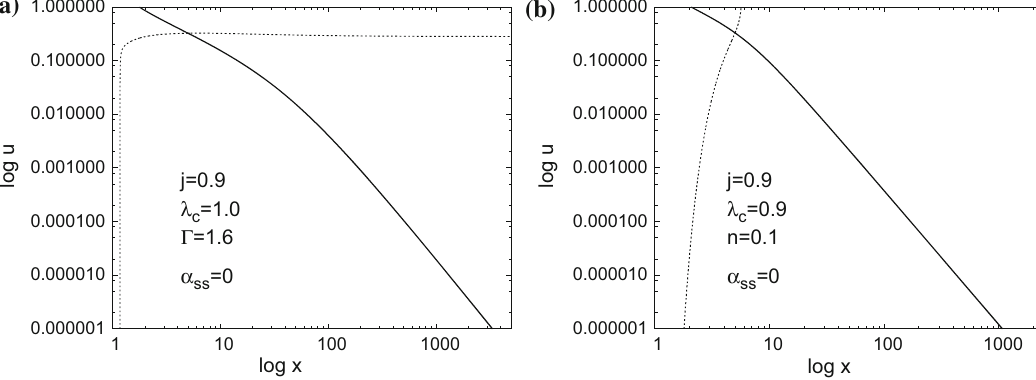
taken to be 10 7 M (cid:5) –10 9 M (cid:5) and the sub-Eddington accretion rates such